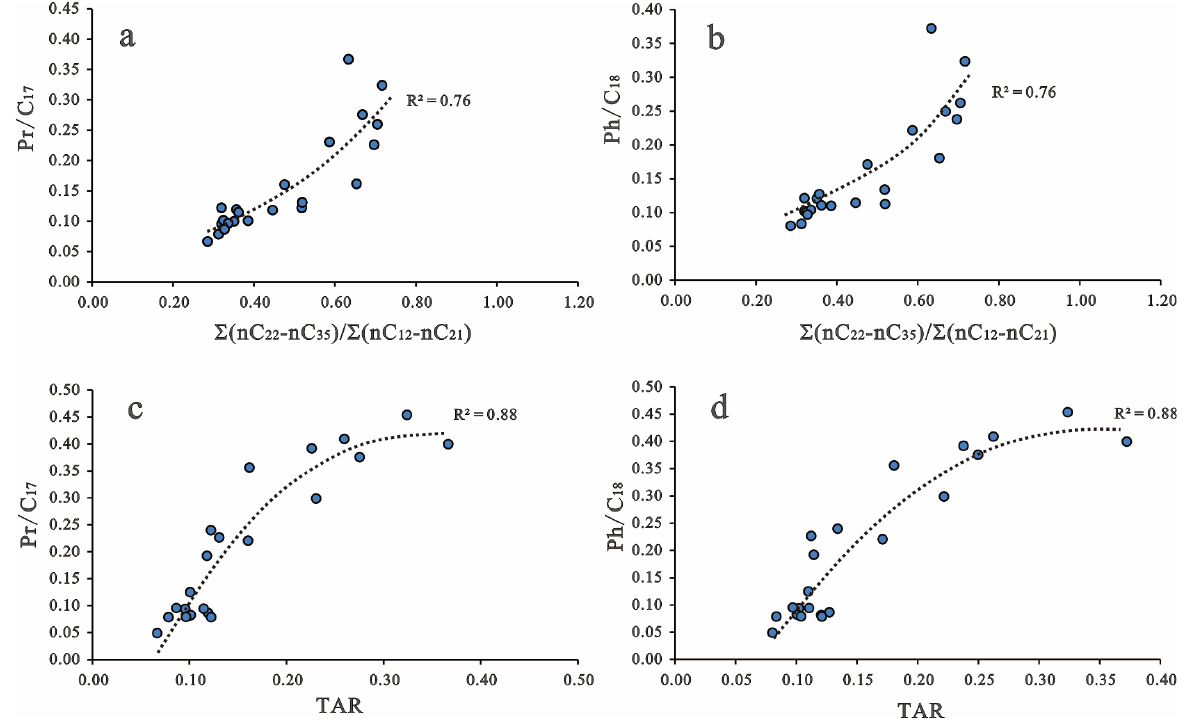
Figure 8. Cross-plots: ( a ) the wax indexes versus Pr/C 17 ; ( b ) the wax indexes versus Ph/C 18 ; ( c ) TAR versus Pr/C 17 ; ( d ) TAR versus Ph/C 18 .